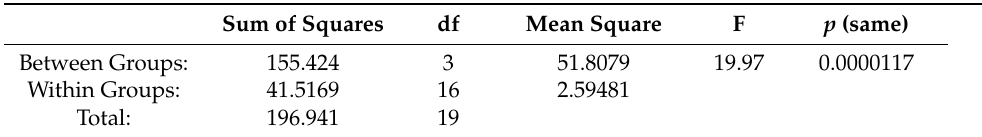
Figure 12. SEM micrographs of the fracture surface of composites with 20% CHFW after the following treatments: ( a ) in natura; ( b ) NaOH 5; ( c ) HYD 30; ( d ) BIO 24. Table 5. Variance analysis of average elastic modulus obtained for tensile strength of composites with 20% treated and untreated CHFW.